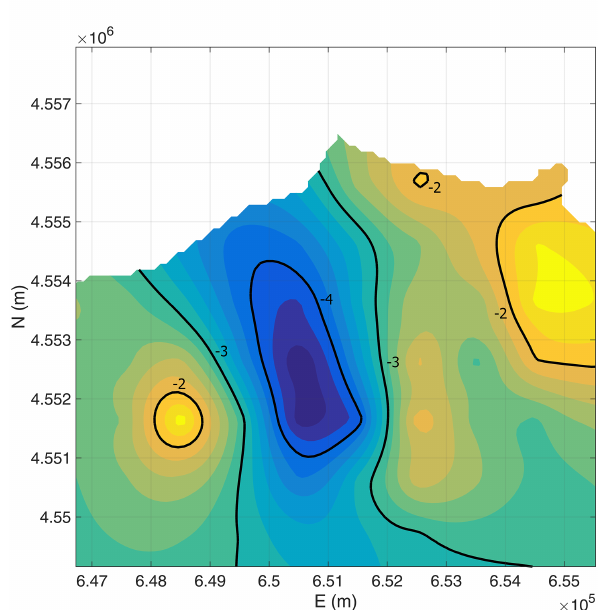
Figure 8. Map of log10 of aquifer transmissivity determined by means of the inverse modeling algorithm.